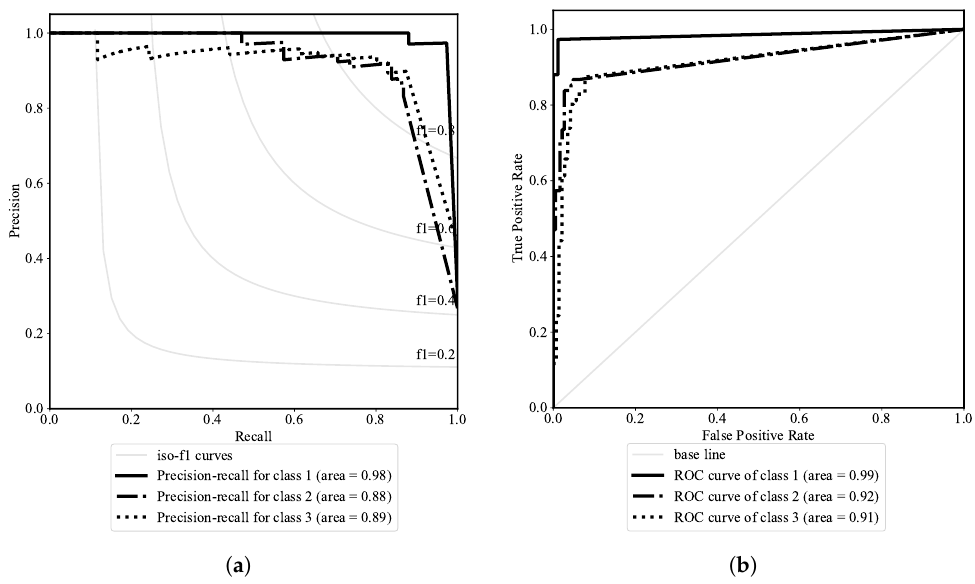
Figure 8. Performance of M HT ( FRC , RN ) in terms of: ( a ) Precision-Recall Curve; ( b ) ROC